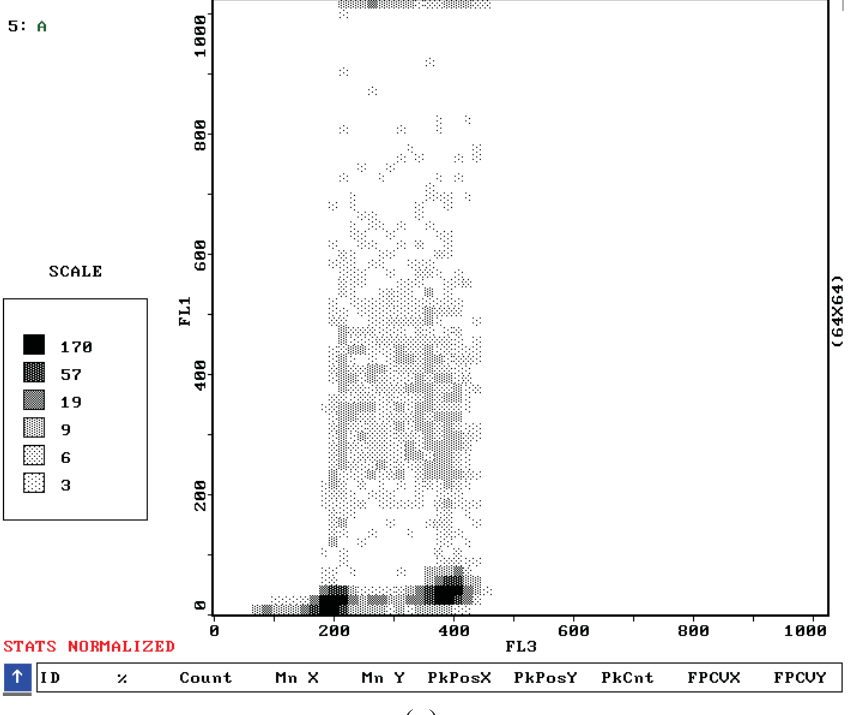
Figure 3. ( a ) incorporation of BrdU in control cells; ( b ) Incorporation of BrdU in cells treated with 10mL/L polyphenol of CR